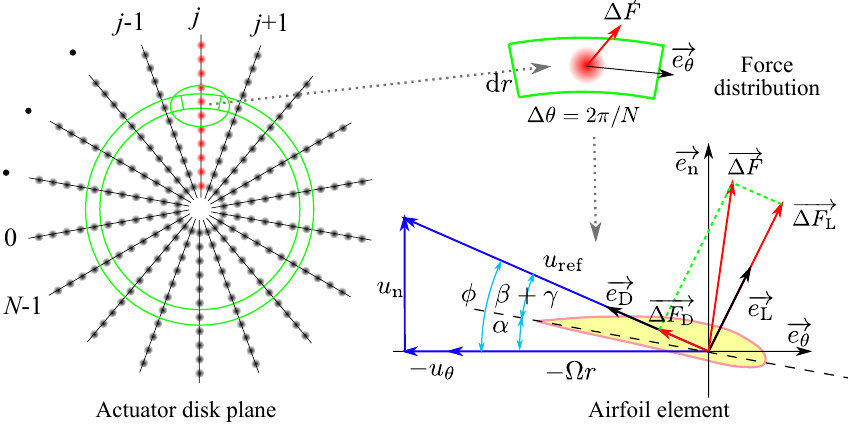
Figure 1. Schemtaics of the Blade Element Theory (BEM)-based actuator disk